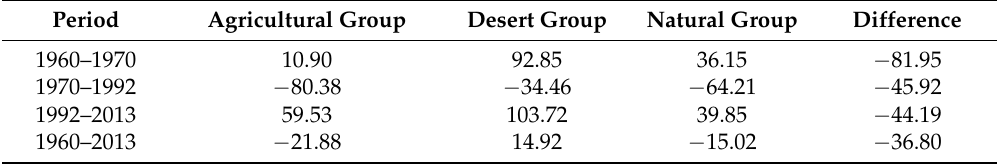
Table 4. A comparison of ET0 trends (mm/decade) between the station groups in different time periods. Period Agricultural Group Desert Group Natural Group